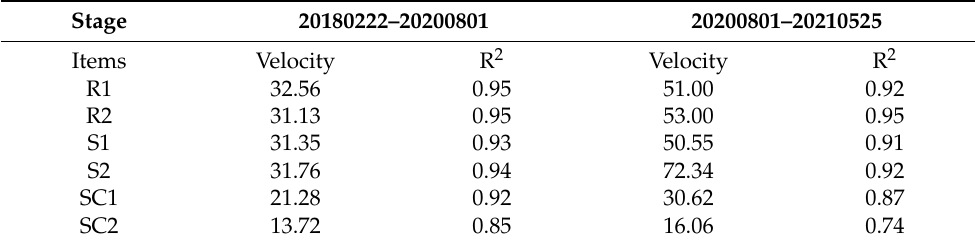
Table 2. Stage analysis of the cumulative LOS displacement